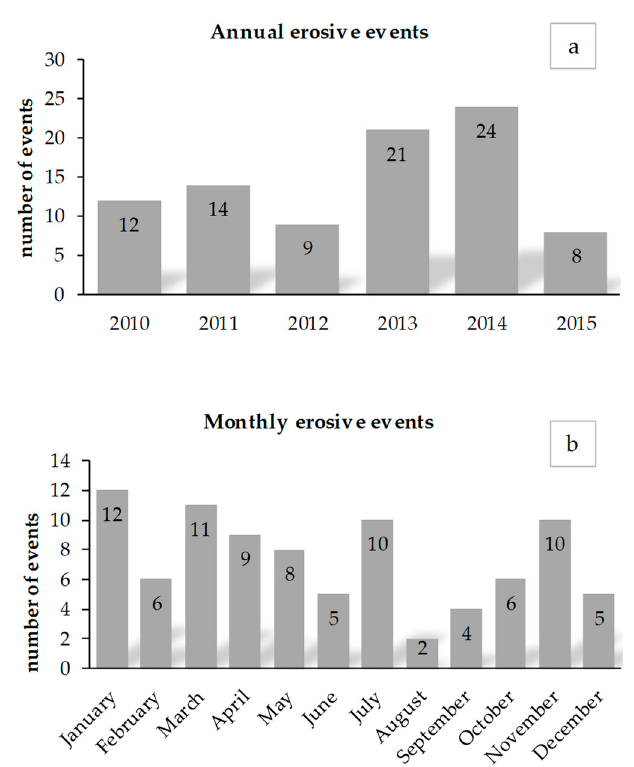
Figure 2. Annual erosive event distribution ( a ) and total monthly erosive event distribution ( b ) for the study period.